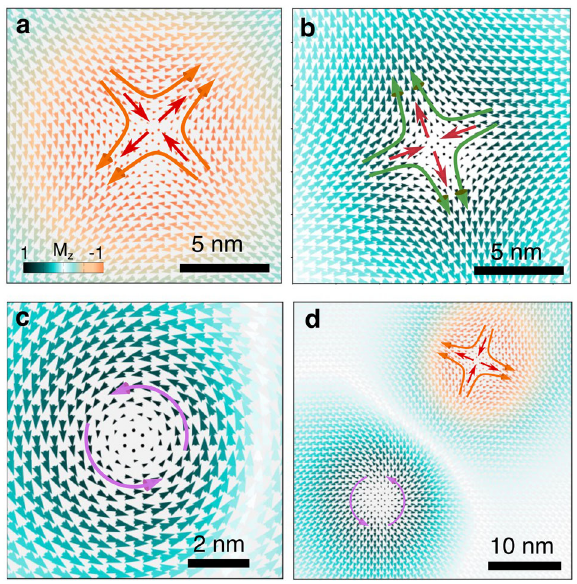
Fig. 4 Large timescale evolution of merons and antimerons. a – d Spin dynamics at long times (1.25 − 2 ns) showing the dynamics of the topological spin textures after the application of a laser pulse of fl uence 0.01 mJ cm − 2 . The topological number N is computed at each snapshot. The small highlighted areas (1, 2, 3, 4, 5) display speci fi c events of the interactions between vortex and antivortex. Zoom-in at the small areas showing an annihilation event ( e, h ) followed by the emission of spin-waves, collisions between two pairs of vortex and antivortex ( f ), collision between single vortex and antivortex ( g ) and precession of vortex and antivortex pair ( i ). See Supplementary Movie S2 for additional